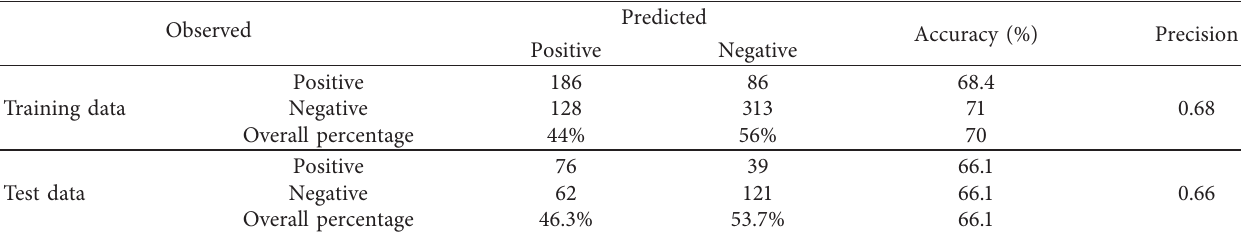
Table 10: Confusion matrix, accuracy, and precision of the law enforcement sign model.